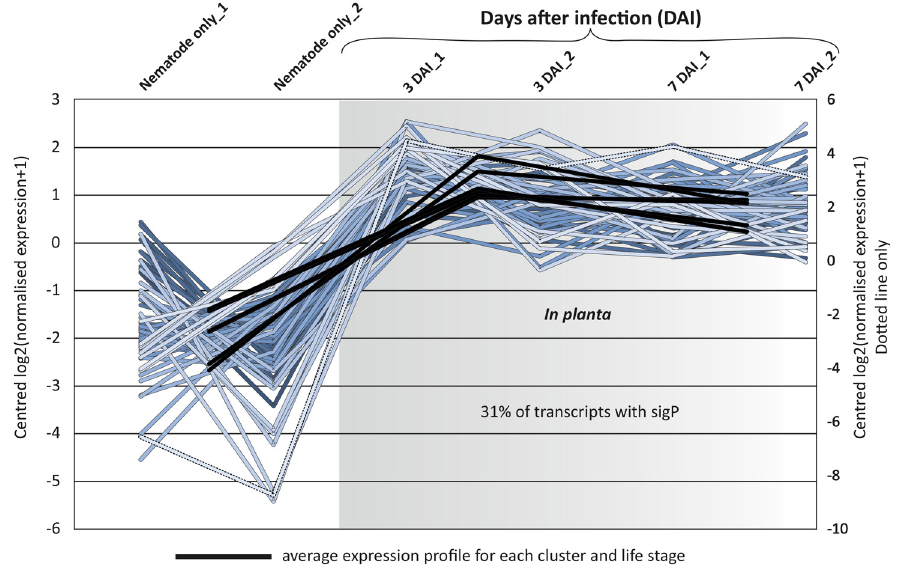
Fig 4. Identification of Pratylenchus penetrans transcripts significantly upregulated in planta . Differential expression analysis was carried out on all transcripts in the P . penetrans transcriptome. Those differentially expressed at a significant level (FDR p < 0.001, min fold change 2) were grouped into various expression clusters. Here, 5 clusters, each with variations in magnitude of the same biologically relevant expression profile contains a total of 58 trinity components. The average for each cluster and each life stage is indicated by black bars. Of these transcripts upregulated, 31% encode proteins with putative signal peptides for secretion; a 3.5 fold enrichment over the rest of the